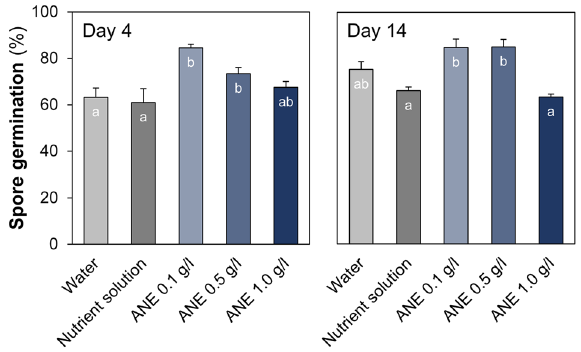
Figure 1. R. irregularis spore germination at days 4 and 14 grown on agar with treatments as labelled, each treatment comprising 6 replicate Petri dishes containing > 80 AMF spores (letters indicate Tukey’s post-hoc test significance groups, α = 0.05, following analysis of